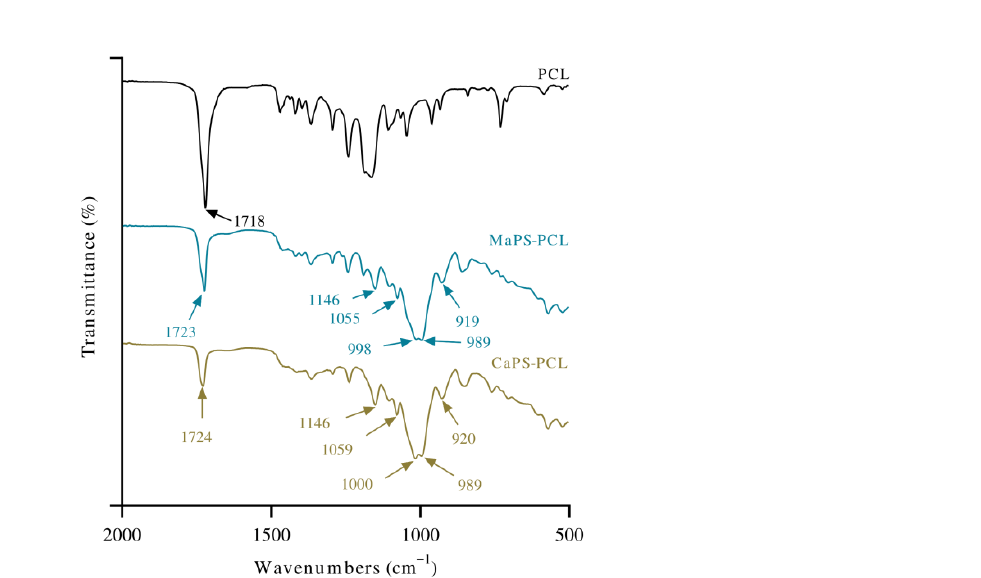
Figure 2. Infrared spectra of the blends CaPS–PCL and MaPS–PCL. PCL was included as a reference.